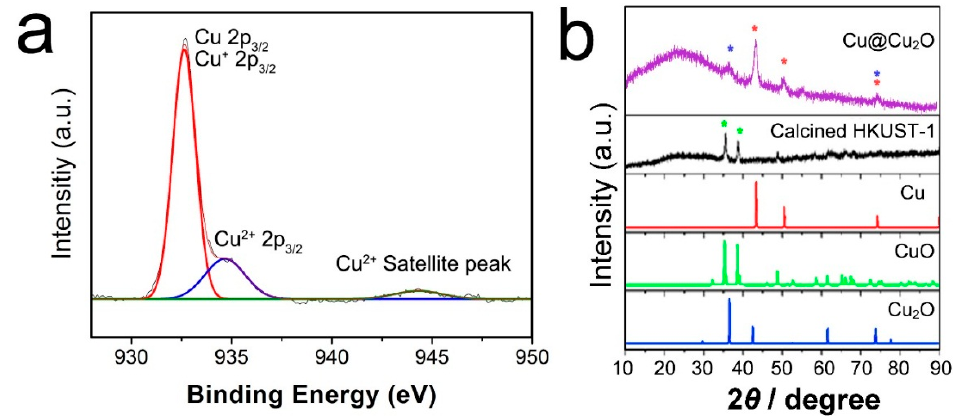
Figure 3. XPS Spectrum of ( a ) Cu@Cu 2 O and X-ray diffraction (XRD) patterns of ( b ) Cu@Cu 2 O and calcined HKUST-1.